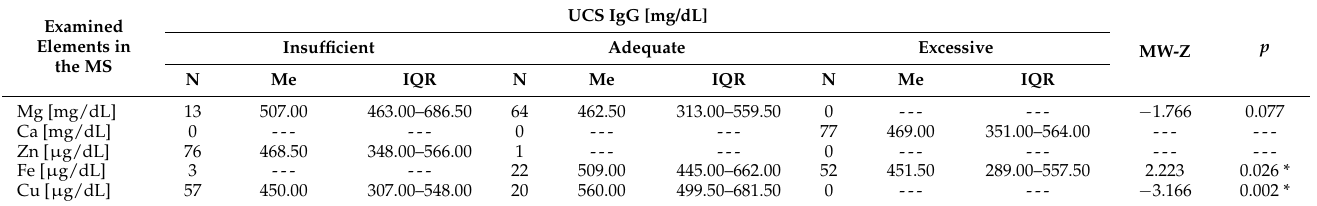
Table 5. The concentration of IgG antibodies in the UCS in relation to the concentration of macro- and microelements in the MS (insufficient, adequate and excessive).